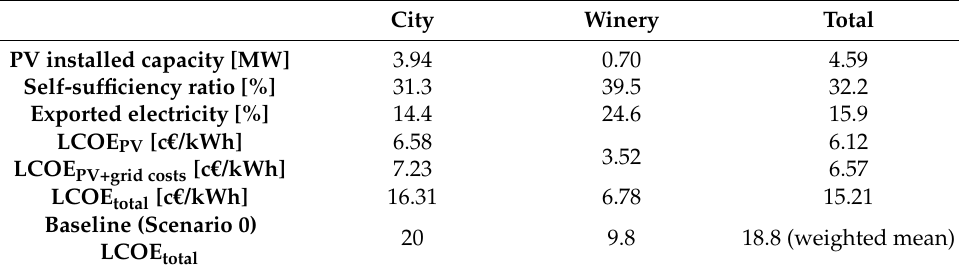
Table 4. Numerical results for scenario 1 (independent self-consumption). City Winery Total PV installed capacity